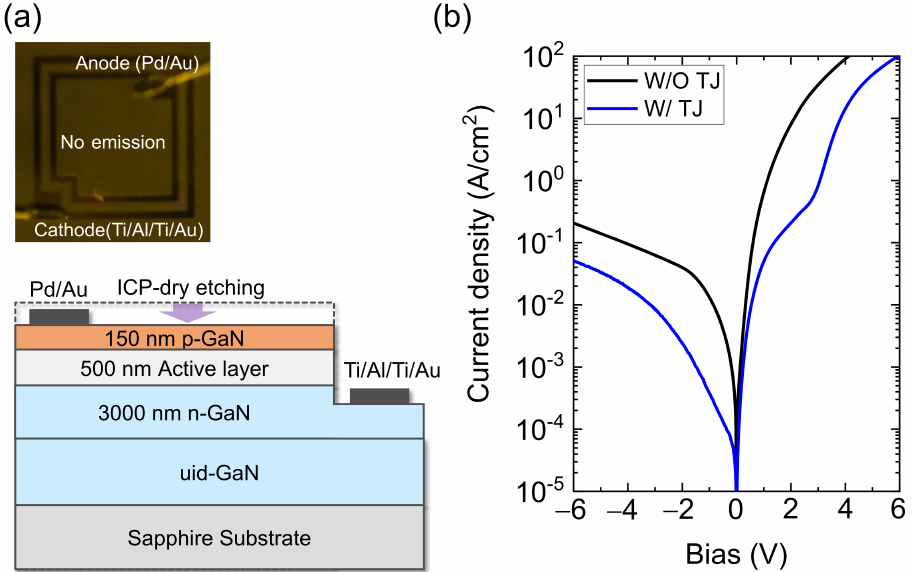
Figure 5. ( a ) A cross-sectional schematic and optical microscope image of the p-type GaN surface etched LED (reference). ( b ) Current density–voltage characteristics of the reference LED and tunneling junction (TJ) contact